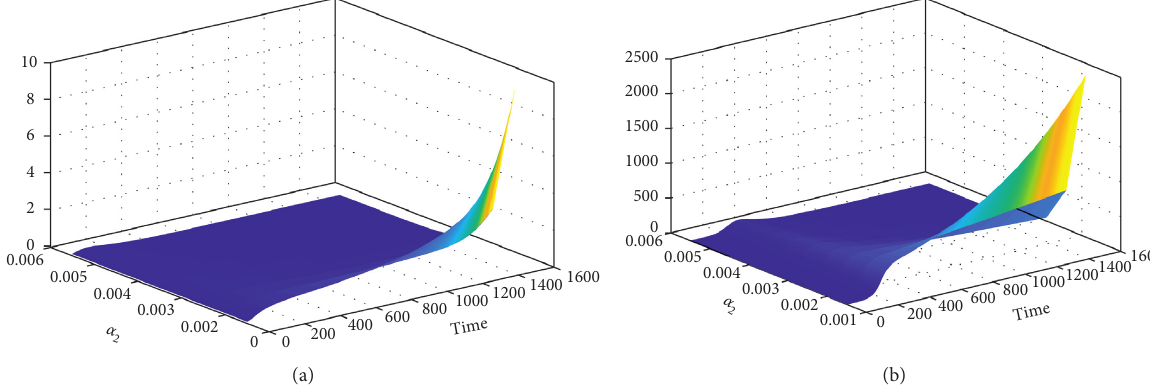
Figure 5: Amount of the information as a function of time and α controls.